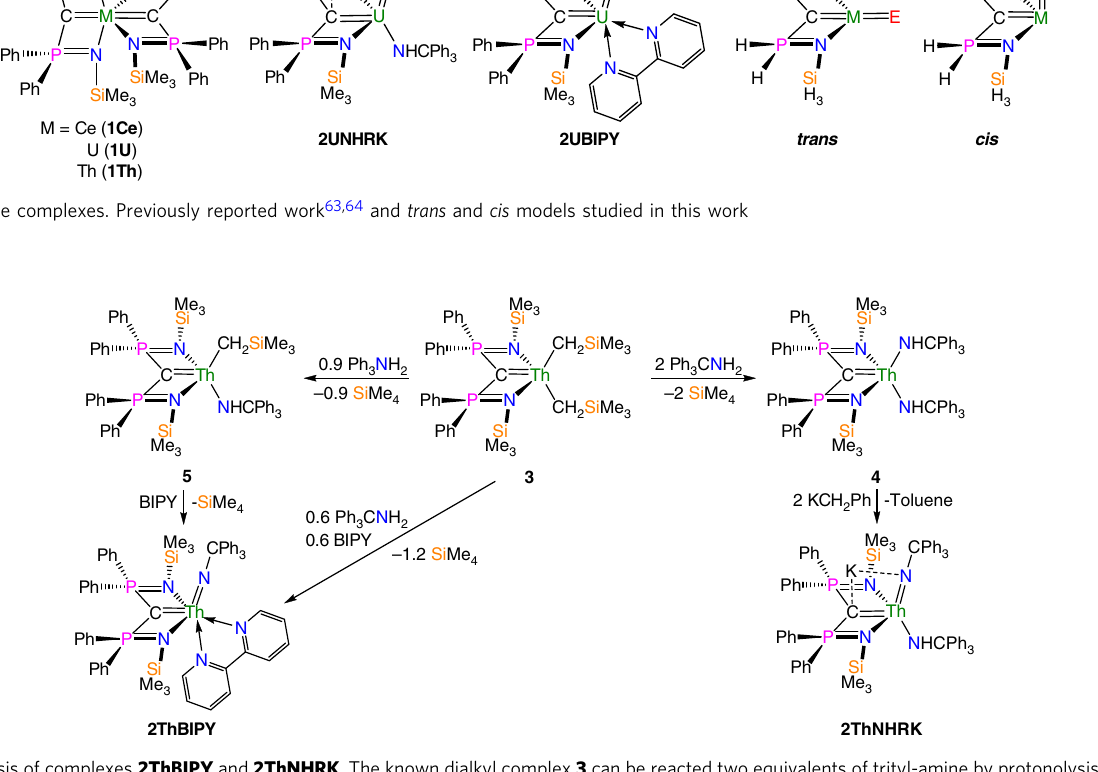
Fig. 2 Synthesis of complexes 2ThBIPY and 2ThNHRK . The known dialkyl complex 3 can be reacted two equivalents of trityl-amine by protonolysis to give the diamide complex 4 . Complex 4 when treated with two equivalent of benzyl potassium (to maximise the yield, a stoichiometric amount of benzyl potassium gives lower yields) converts to the amide-imide complex 2ThNHRK . Complex 3 can alternatively be reacted with a sub-stoichiometric quantity of trityl-amine (to suppress ligand-redistribution reactions) to give, via protonolysis, the mixed alkyl-amide complex 5 . Complex 5 undergoes α -hydrogen abstraction on addition of BIPY to give 2ThBIPY